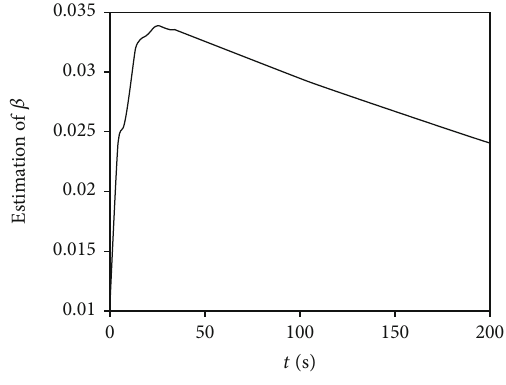
Figure 5: Estimation of β .